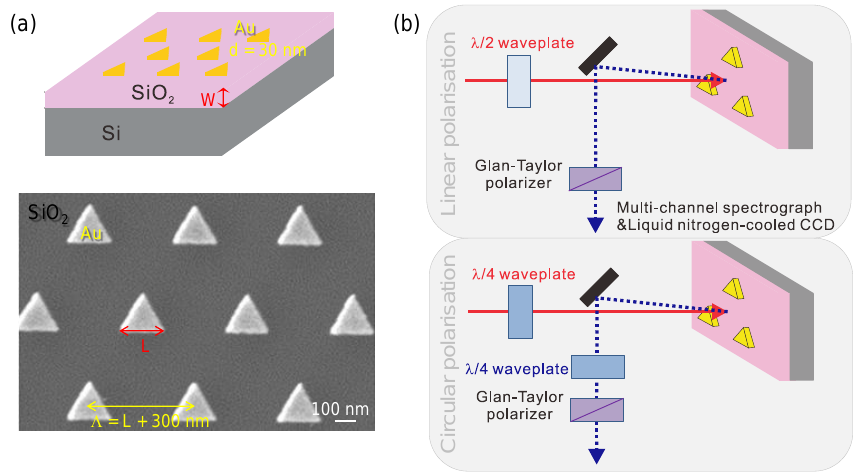
Figure 1. ( a ) Schematic of the sample (top) and an SEM image of the triangular Au nanoparticles (bottom). The spacer of SiO 2 with width w = 200,300 nm was deposited on the Si substrate to control the E-field enhancement at the plasmonic Au triangular nanoparticles. The pattern was triangular with period Λ = L + s where separation between nanoparticles was s = 300 nm and the side-length of the triangle was L = ( 120 − 220 ) nm changed in steps of 20 nm. Thickness of Au nanoparticles made by electron beam lithography (EBL) and lift-off was d = 30 nm. ( b ) Setup to detect second harmonic generation (SHG) from the metasurfaces under the linearly and circularly polarised excitation. The second harmonic light was analysed at ≈ 1 ◦ reflection to the normal. This setup was used to maximise collection of the second harmonic. The excitation light source was Ti:sapphire fs-laser with the wavelength tunable from 730 to 920